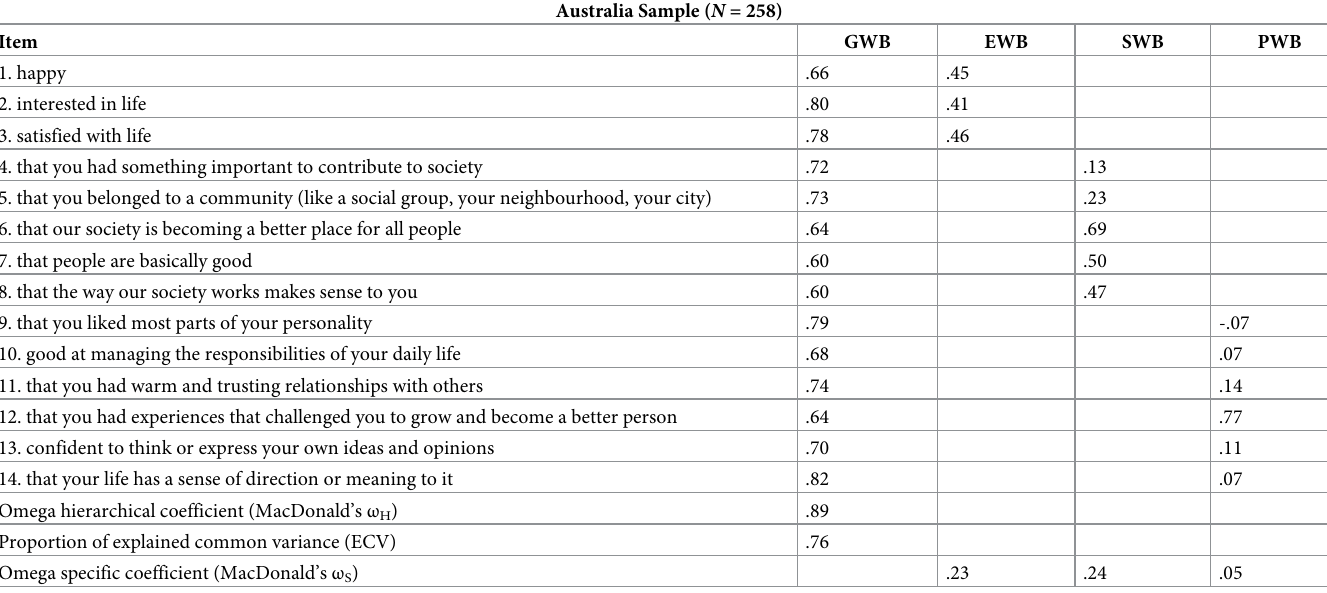
Table 6. Standardised factor loadings, Macdonald’s omega hierarchical and specific coefficients, and explained common variance of the bifactor model of the MHC-SF (Australia